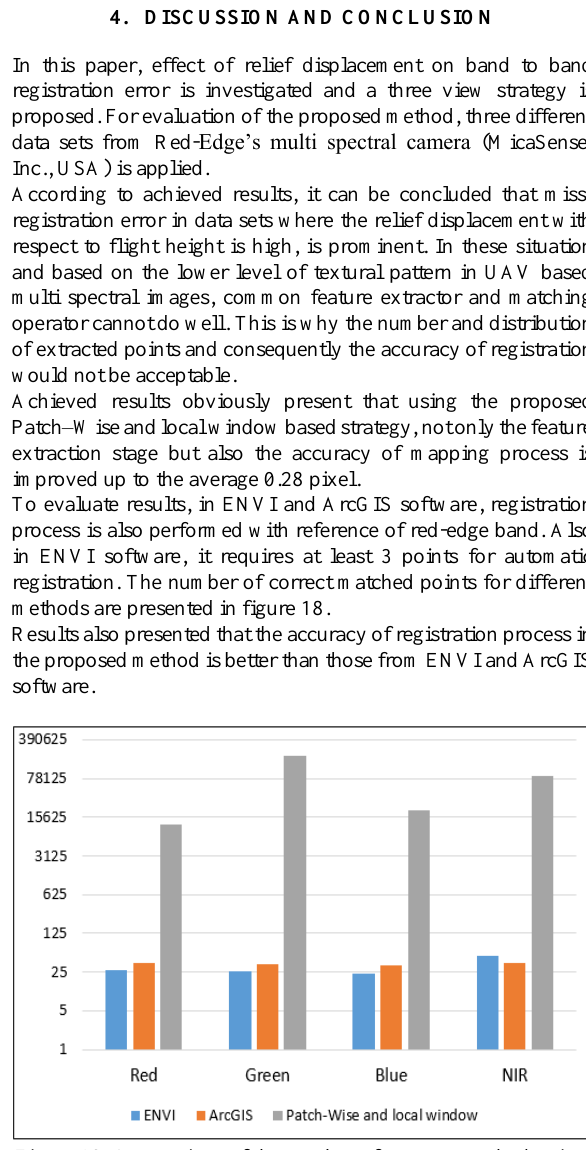
Figure 18. Comparison of the number of correct matched points between Patch-Wise and local window strategy with ENVI and ArcGIS software